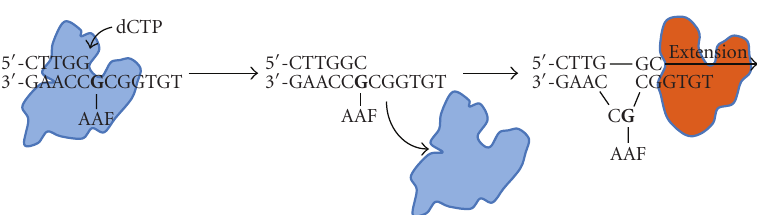
Figure 5: Mechanism for bypass of a dG-C8-AAF adduct in the Nar I sequence. A polymerase more suited for incorporation across from the adduct places a proper dCTP:G base pair at the adducted position followed by incorporation, then dissociation of the enzyme. A subsequent rearrangement of the DNA to form a 2 nucleotide budge ensues, allowing a possible second polymerase to perform extension from this slipped structure, resulting in a − 2 deletion frameshift product.